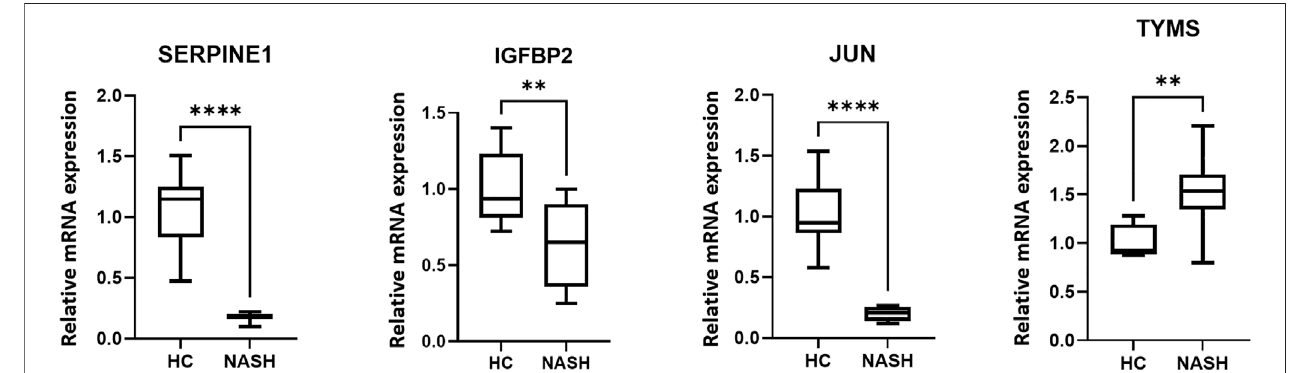
FIGURE 8 | Gene expression in a mouse model of NASH and in HC. **** p < 0.0001, **p <